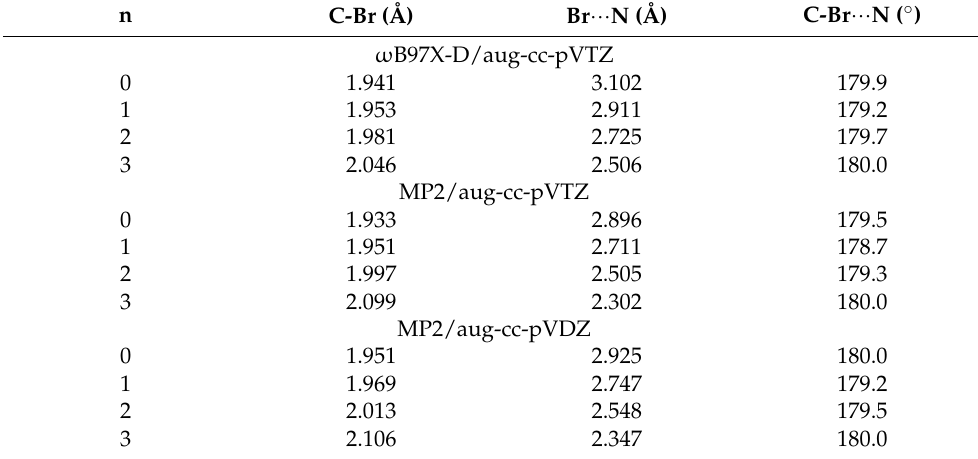
Table 3. Optimized geometries for the CH 3 − n (CN) n Br ··· NMe 3 complexes; C-Br bond lengths, Br ··· N distances and C-Br ··· N angles are given.